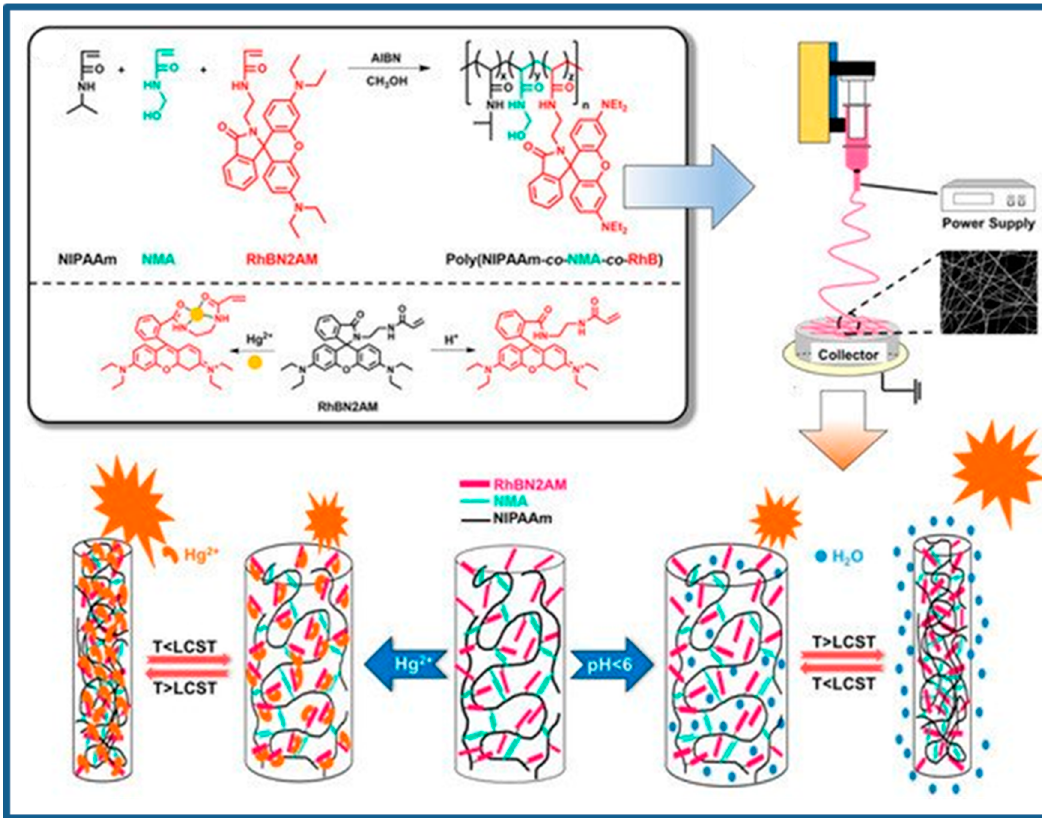
Figure 5. Random copolymer (poly(HEMA-co-NMA-co-RhBN2AM) synthesis and optical sensor fabrication and its potential applications in sensing Hg 2+ and temperature. Reprinted from work in [115] with permission from MDPI.